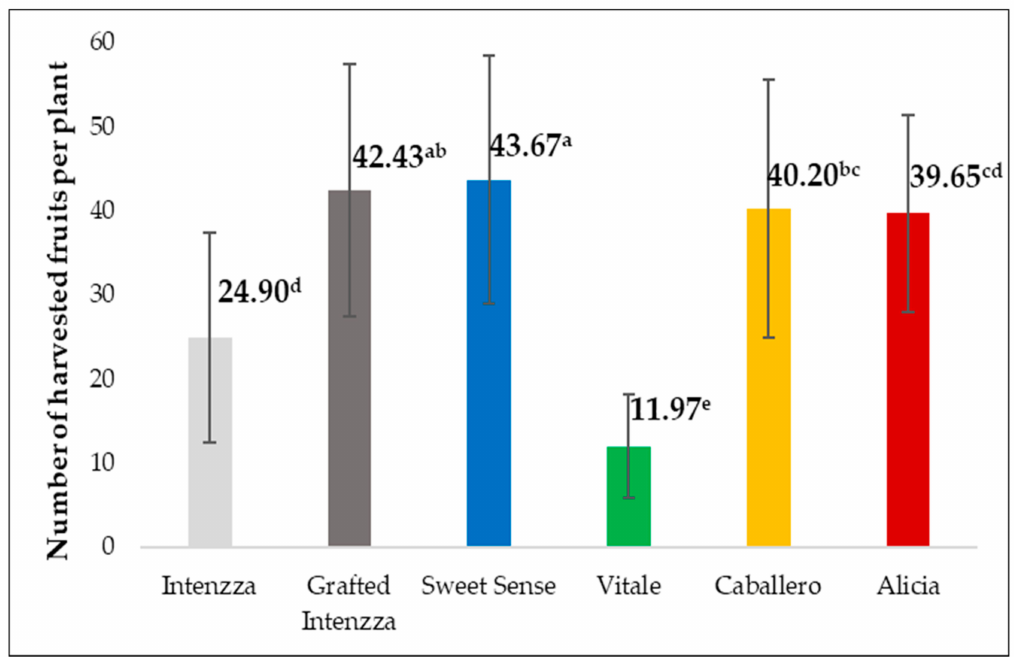
Figure 5. Harvested fruits per plant of the five cultivars of papaya cultivated under greenhouse. Di ff erent letters mean significant di ff erences, at p -value <